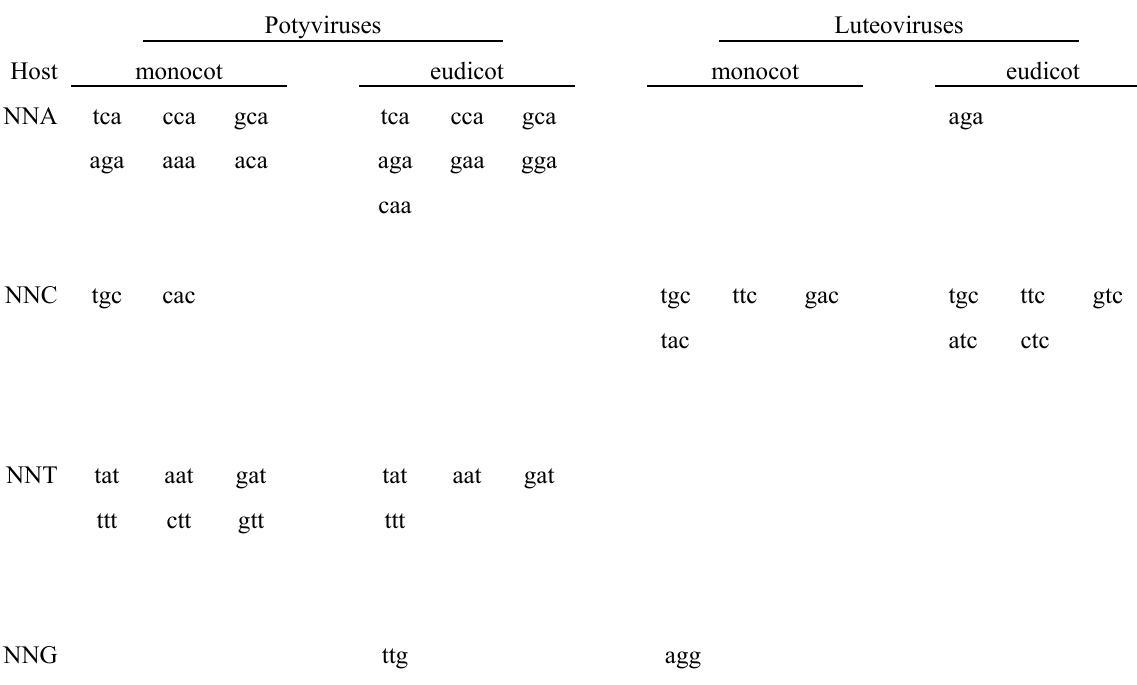
Table 3. Preferred codons in luteoviruses and potyviruses infecting monocot and eudicot hosts. Preferred codons are those with relative synonymous codon usage (RSCU) values